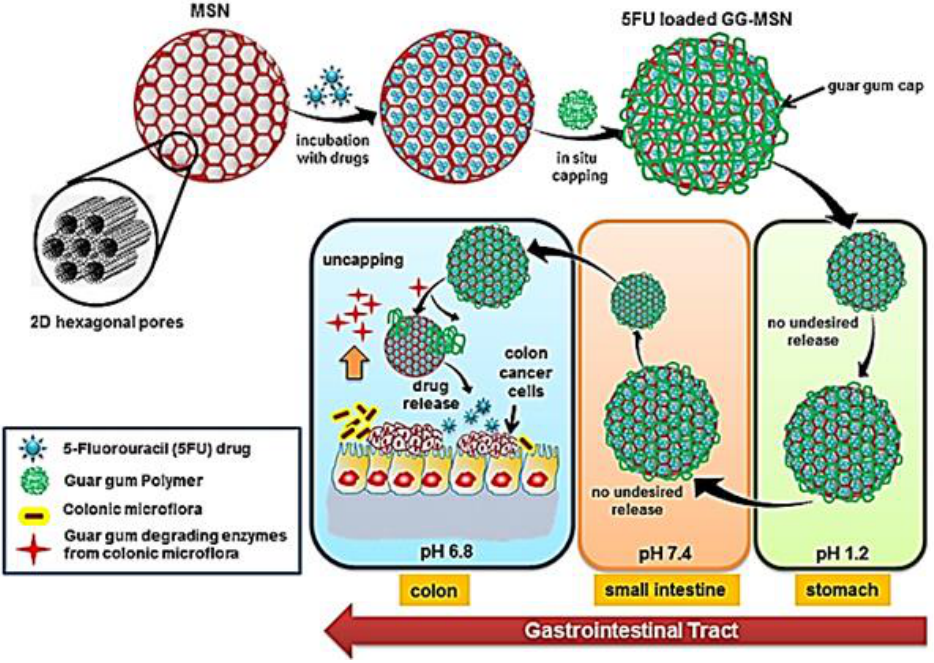
Figure 5. Schematic diagram displaying GG-MSN-based colon specific drug delivery concept, which is activated by colonic enzymes [81], reproduced with permission from Elsevier. is activated by colonic enzymes [81], reproduced with permission from